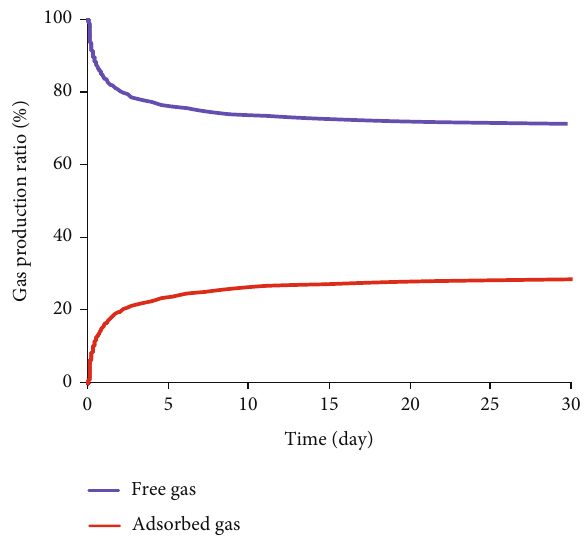
Figure 13: The gas production proportion of tandem cores versus